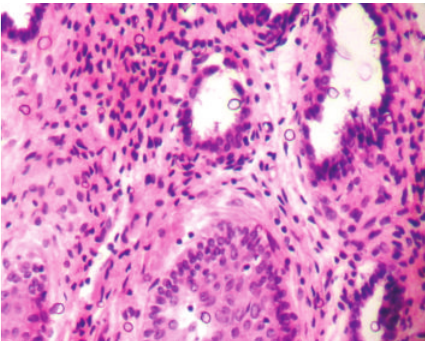
Figure 2: Low power photomicrograph ( × 100) exhibiting glandular structures with